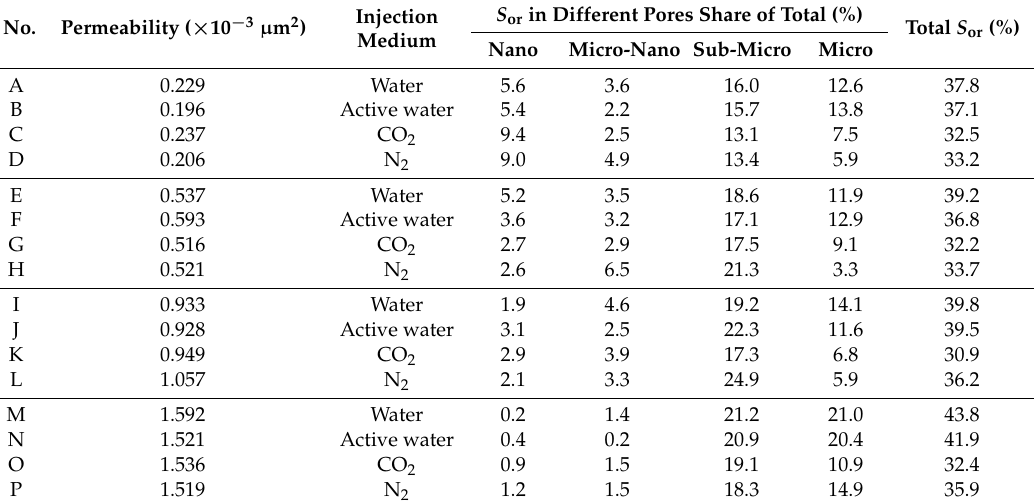
Table 4. Residual oil saturation of tight cores under different injection media.